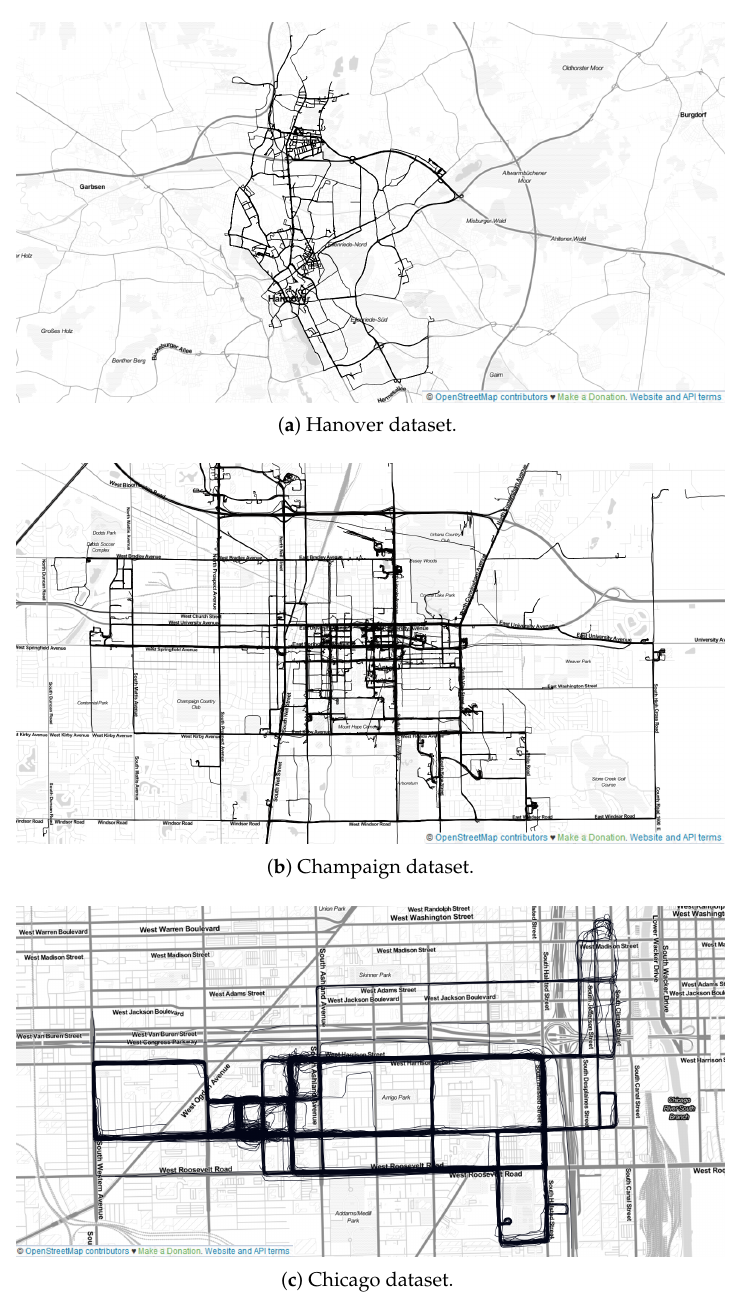
Figure 3. The three datasets that have been used in this